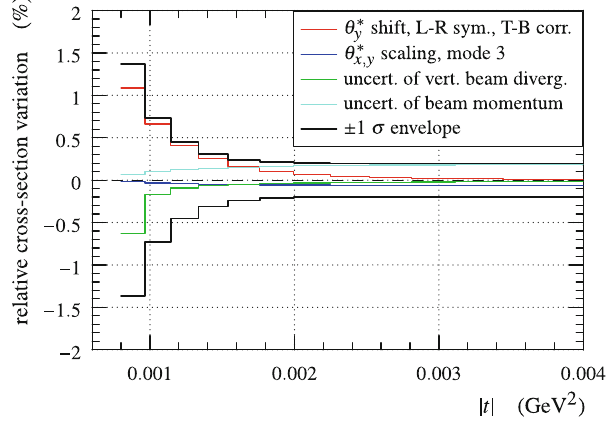
Fig. 11 Relative variation of the final differential cross-section due to systematic uncertainties (medium binning). The colourful histograms represent the leading uncertainties, each of them corresponds to a 1 σ